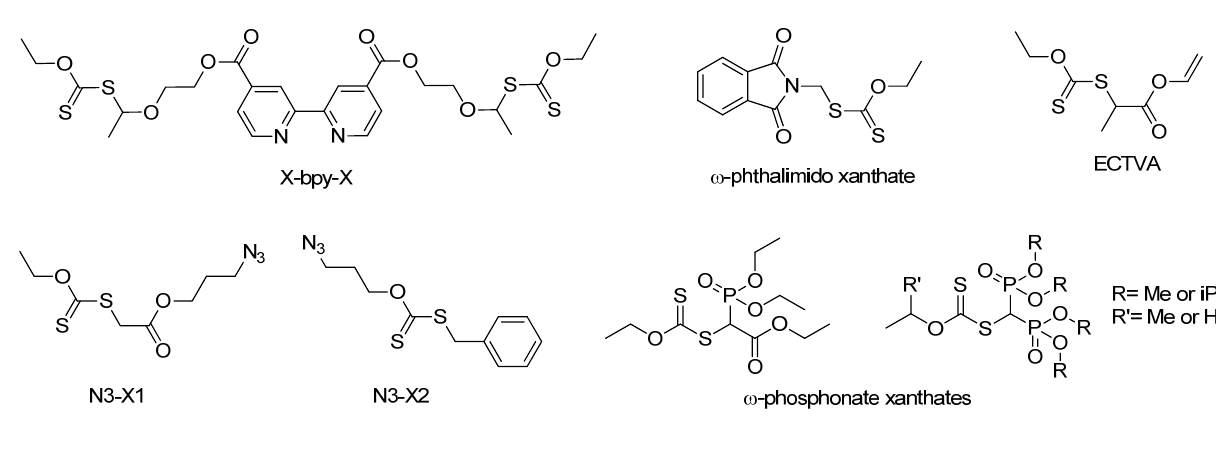
Scheme 8. Structure of ω -functionalized